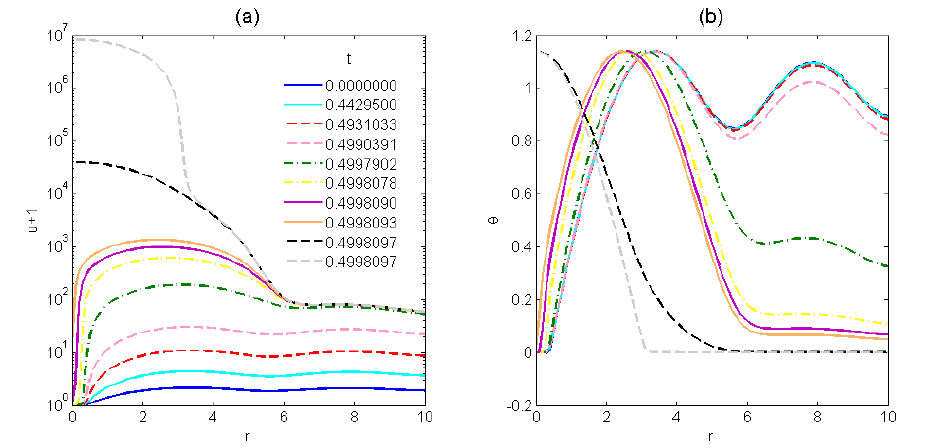
Figure 4. Evolution in time of the self-similar solution u